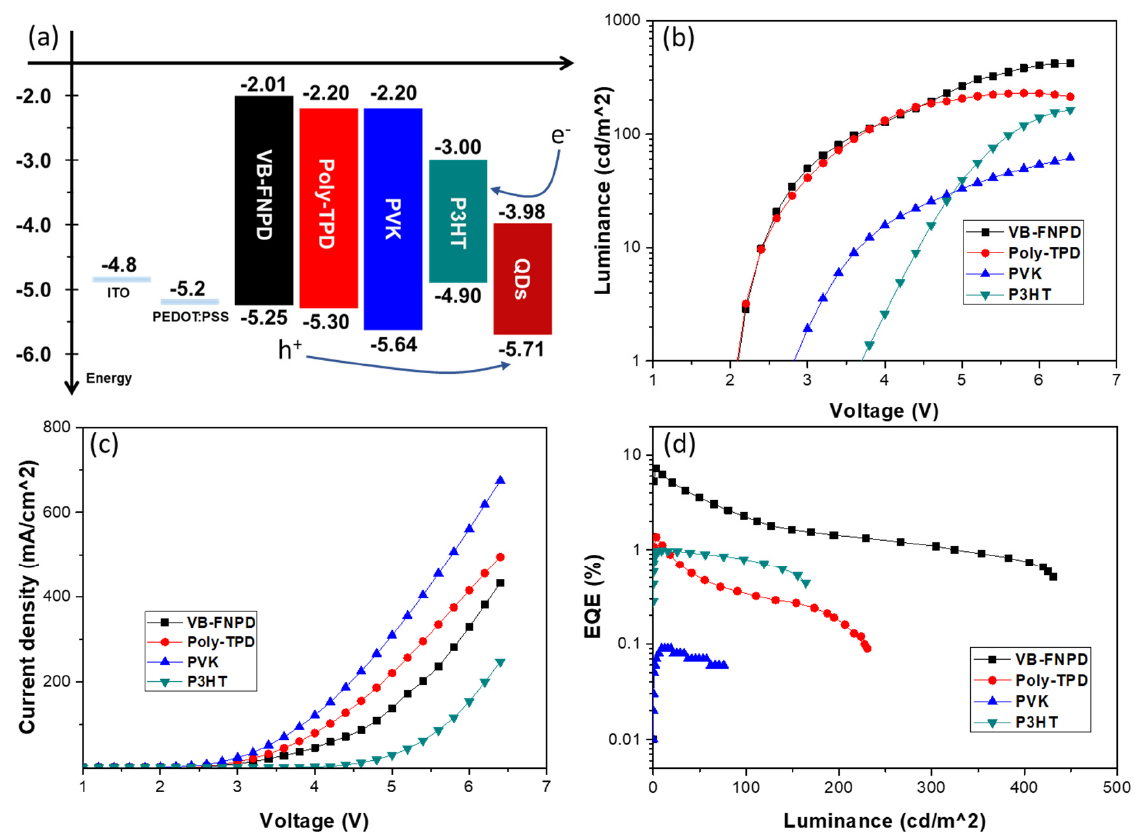
Figure 2. ( a ) Energy levels for different HTLs, ( b ) luminance-voltage (L-V), ( c ) current density-voltage (J-V) and ( d ) external quantum efficiency (EQE) for IPQLED devices with different HTLs.